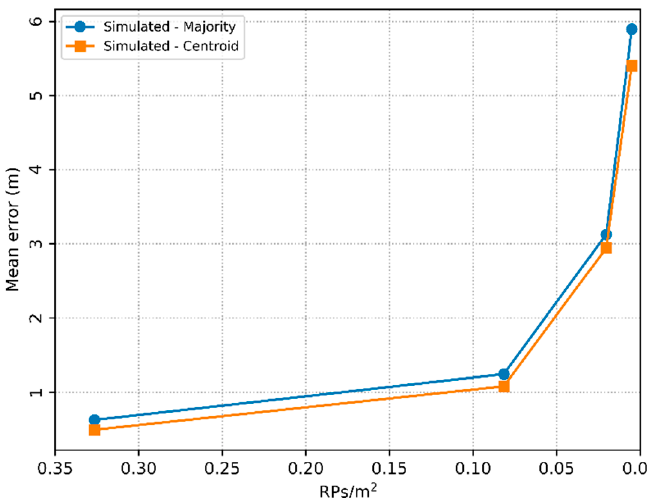
Figure 15. Sensors 2020 , 20 , x FOR PEER REVIEW